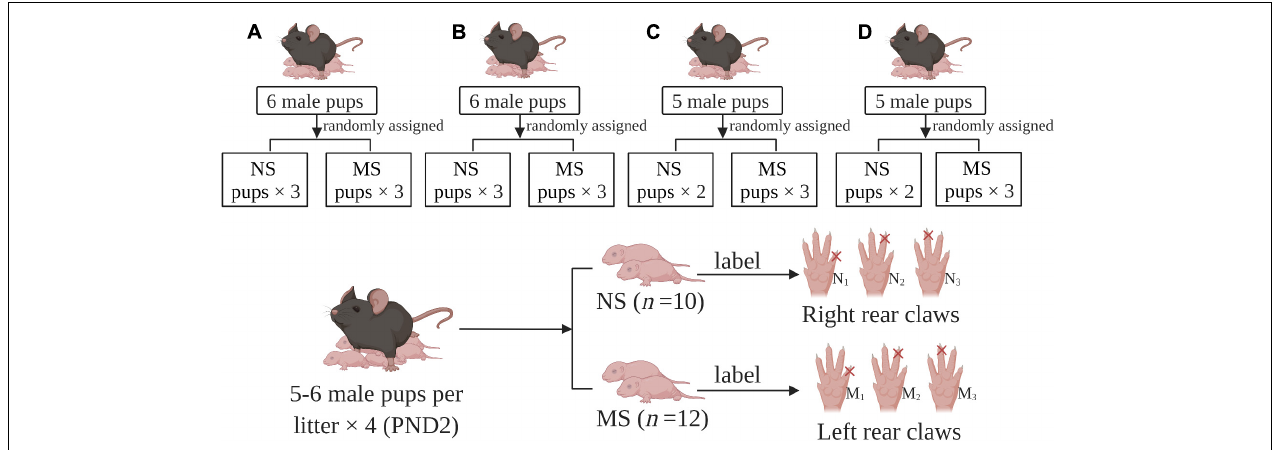
FIGURE 1 | Group assigned and labels. (A–D) gestational mice delivering on the same day were included in the experiments. PND: postnatal day, MS: maternal separation, NS: non-separation, M 1 − 3 : labels for maternal separation pups with one of the left rear claws cut off, N 1 − 3 : labels for maternal separation pups with one of the right rear claws cut